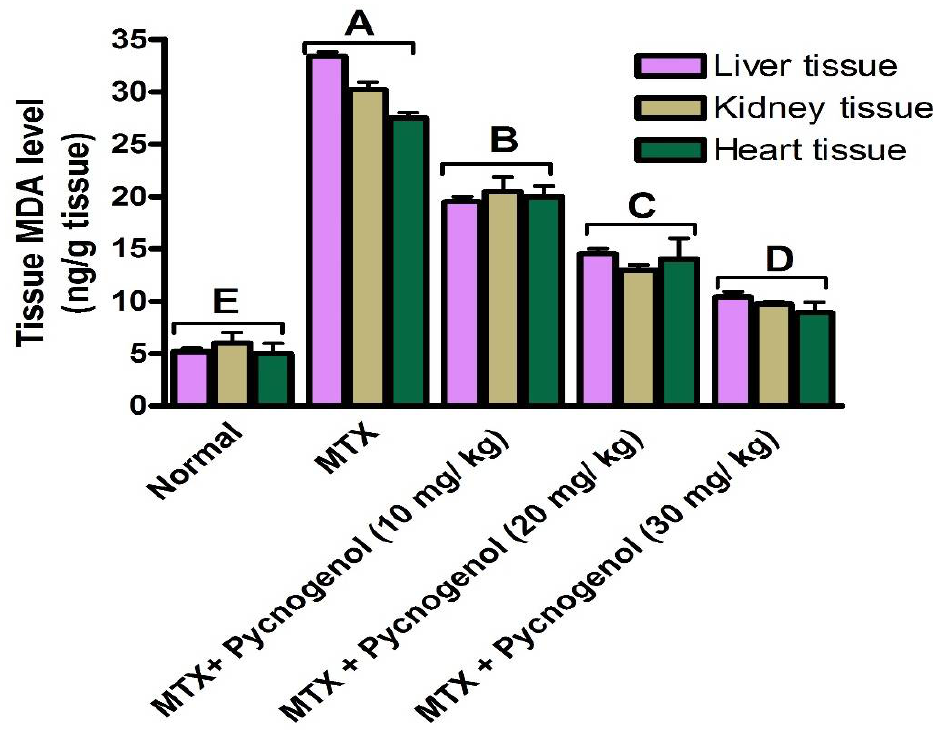
Figure 4. Effect of pycnogenol and/or MTX treatment on the level of MDA biomarker (mean ± SD) in the different tissues. Data are mean ± SD of six rats/group. MDA: malondialdehyde. p value < 0.05 is significant. Bars represent the mean value and the standard error for means. Bars with different letters are significantly different according to DMRTs at p = 0.05.